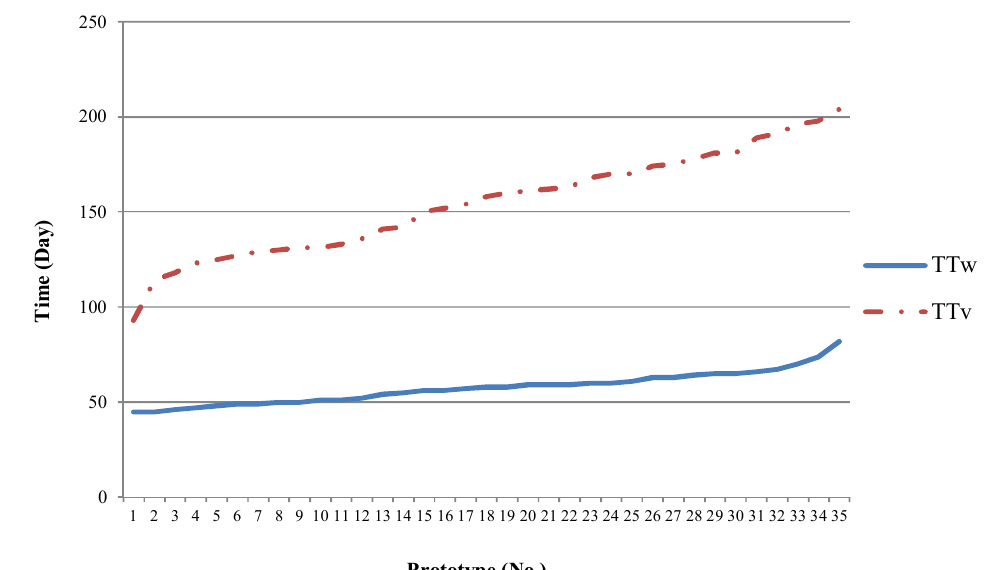
Fig. 9. Comparing the spent time for design, construction, or simulation of hyper tracer robot prototypes based on V-model and